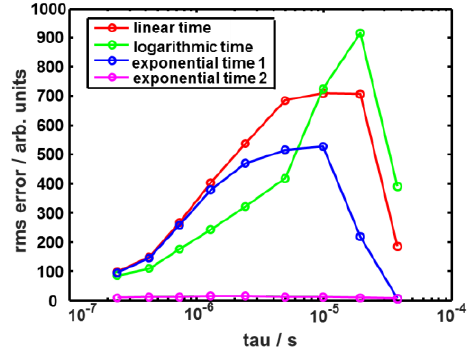
Fig. 5: Simulated errors of time rescaling for single exponential signals. Reconstruction of measured signals is done by shape- preserving